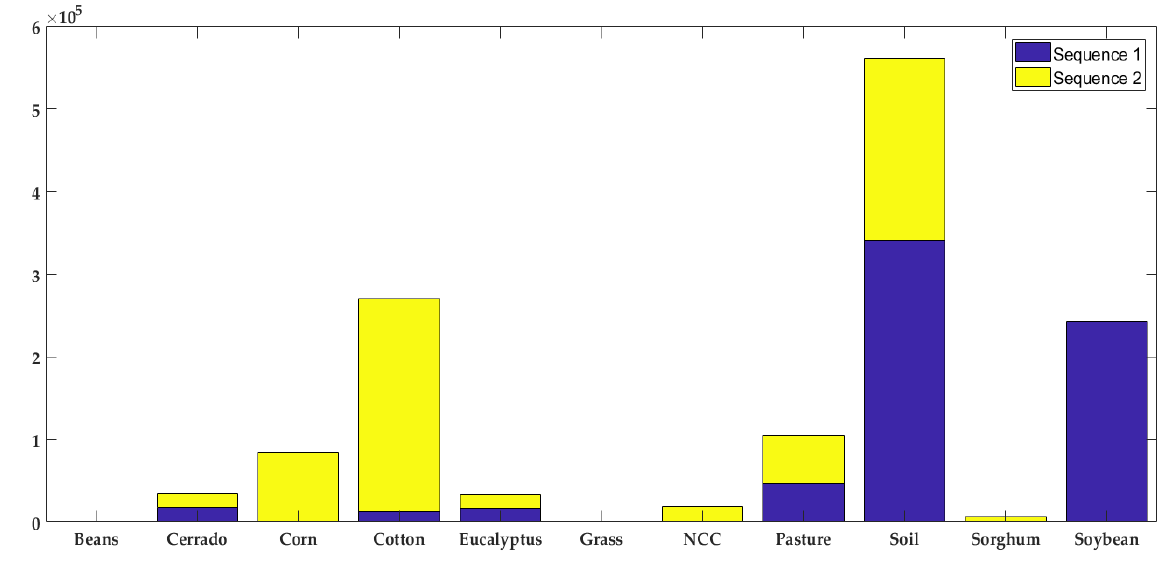
Figure 2. Distribution of the selected classes (soybean, corn, cotton, sorghum, non-commercial crops (NCCs), pasture, eucalyptus, grass, soil, and Cerrado) per image sequence from Campo Verde